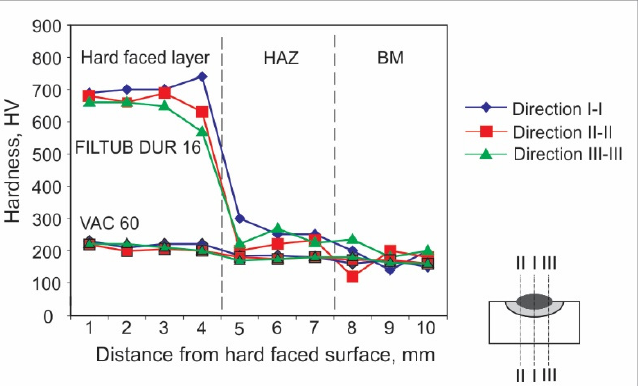
Figure 6. Hardness distribution in the hard-faced layer cross-section, BM-S355J2G3, FM-FILTUB DUR 16, VAC 60.